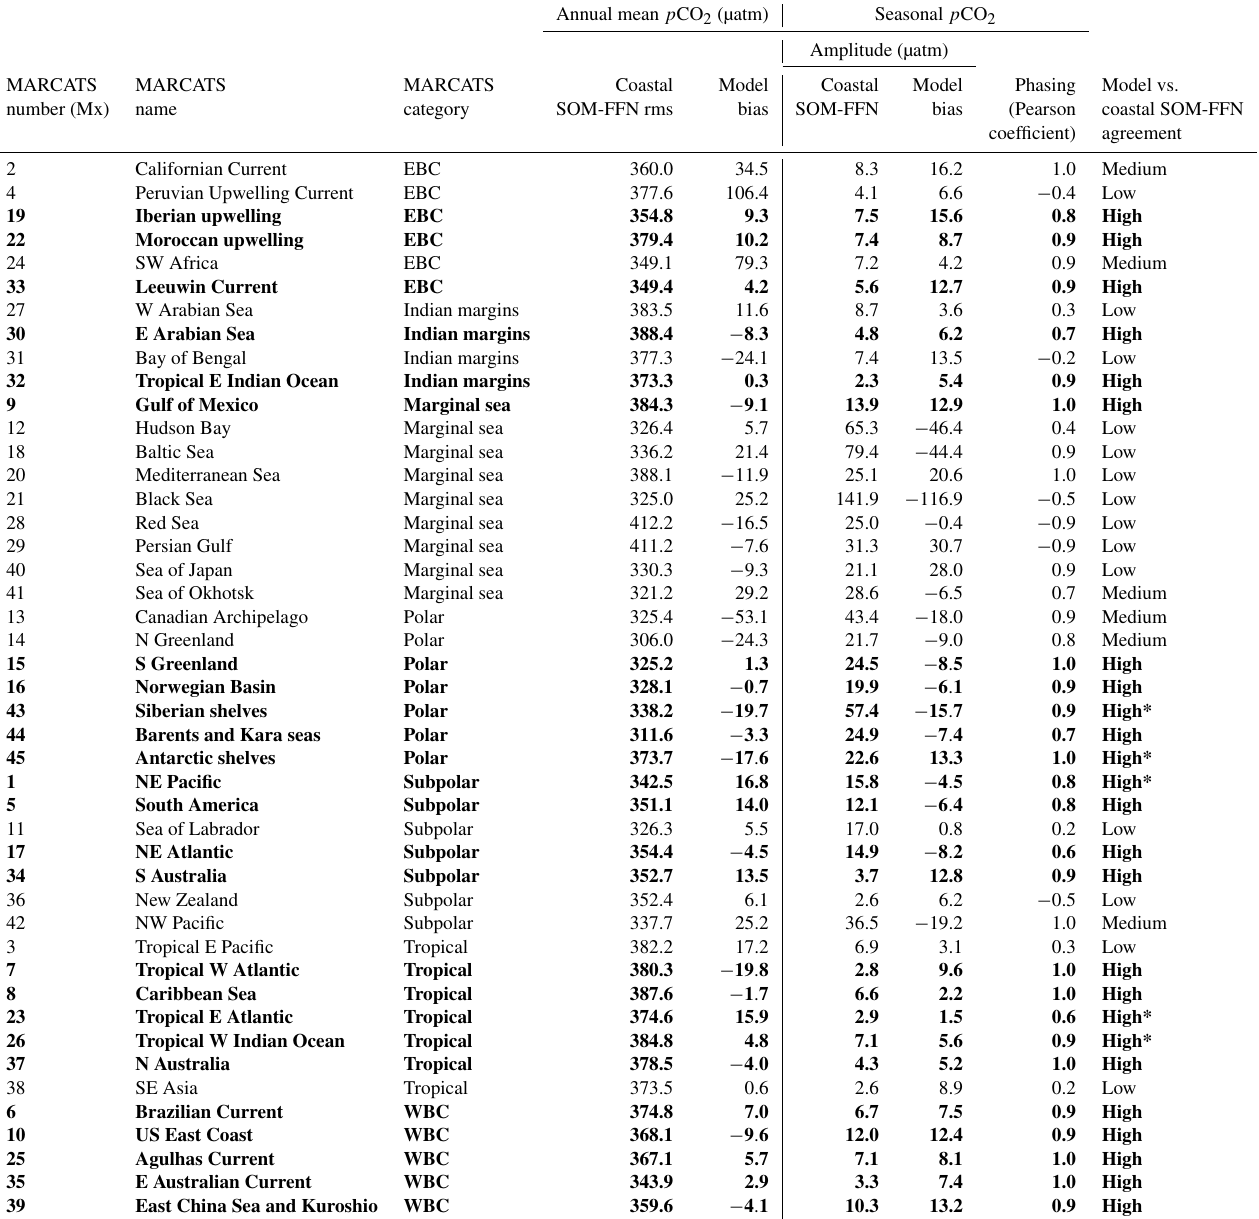
Table 1. Model vs. coastal SOM-FFN agreement level. For each MARCATS region, the agreement (“high”, “medium” and “low”) is at- tributed by the p CO 2 spatiotemporal analysis. Regions where the model fulfills criteria on the annual mean and seasonality are labeled as high-agreement regions (i.e., annual mean mismatch < 20µatm between MOM6-COBALT and coastal SOM-FFN, Pearson correlation coefficient > 0 . 5, and seasonal amplitude mismatch < 20µatm, dots in Fig. 1a). High ∗ -agreement regions can present a bias > 20µatm on the comparison with SOCATv6 (see Table S1 in the Supplement). Medium-agreement regions represent MARCATS regions where the model only fulfills seasonal criteria (seasonal amplitude and phase, dashed in Fig. 1a). Other regions (low agreement) do not fulfill the two criteria associated with the seasonality (no symbol in Fig. 1a). Regions with high agreement are considered the most robust for an in-depth analysis of the processes driving the coastal p CO 2 dynamics and are highlighted in